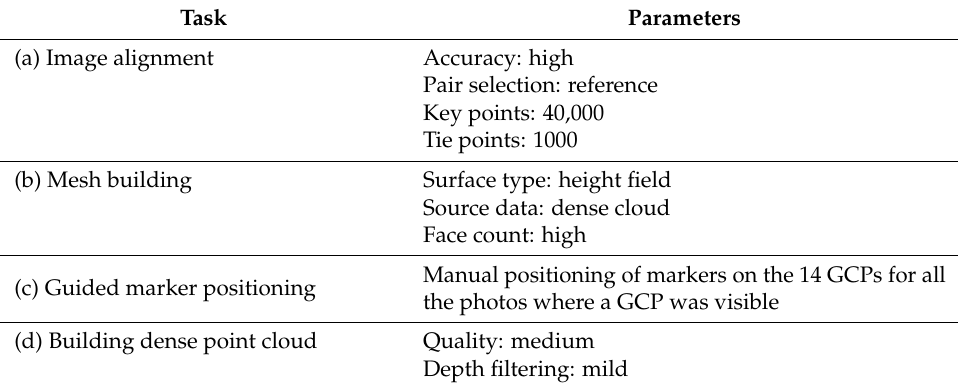
Table 3. Processing steps with corresponding parameter settings in Agisoft Photoscan Professional software for generation of 3D point clouds from unmanned aircraft system (UAS)